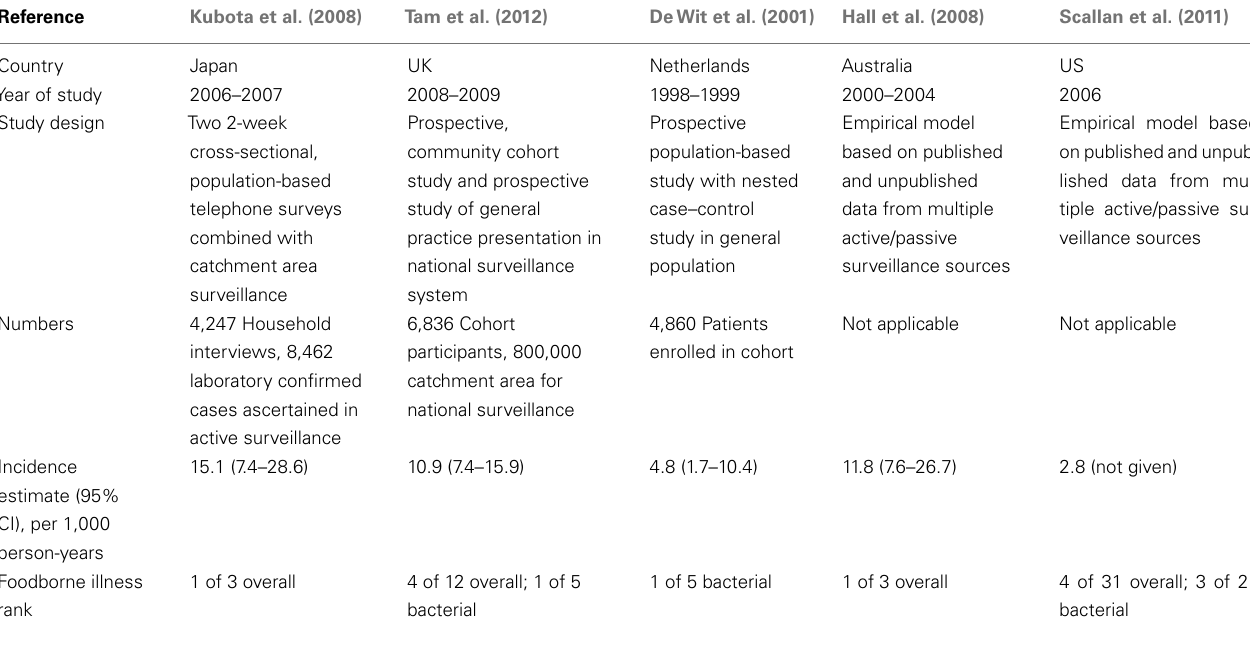
Table 1 | Global estimates of Campylobacter incidence in developed